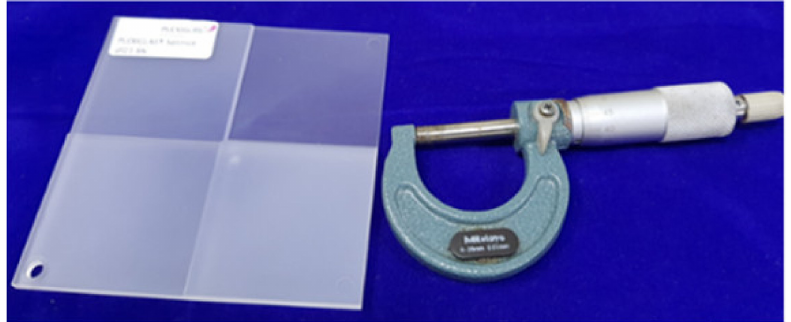
Figure 11. Sensitivity verification under different thicknesses (1 mm, 2 mm, 3 mm, and 4 mm) of IVI Bezel thickness